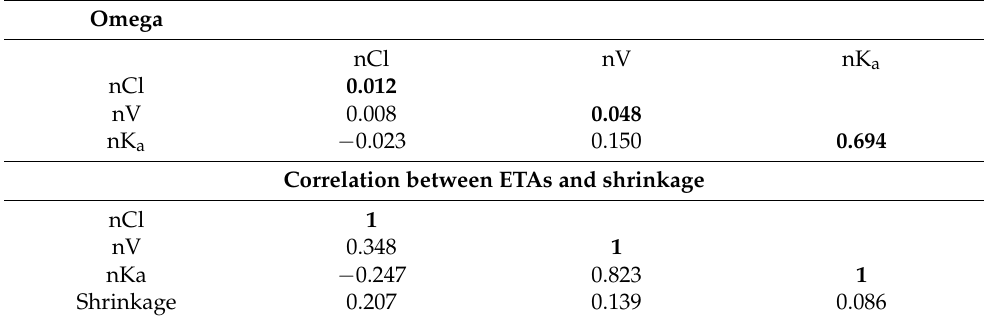
Table 2. Estimates of the random effects variance–covariance matrix, correlation matrix and shrinkage.